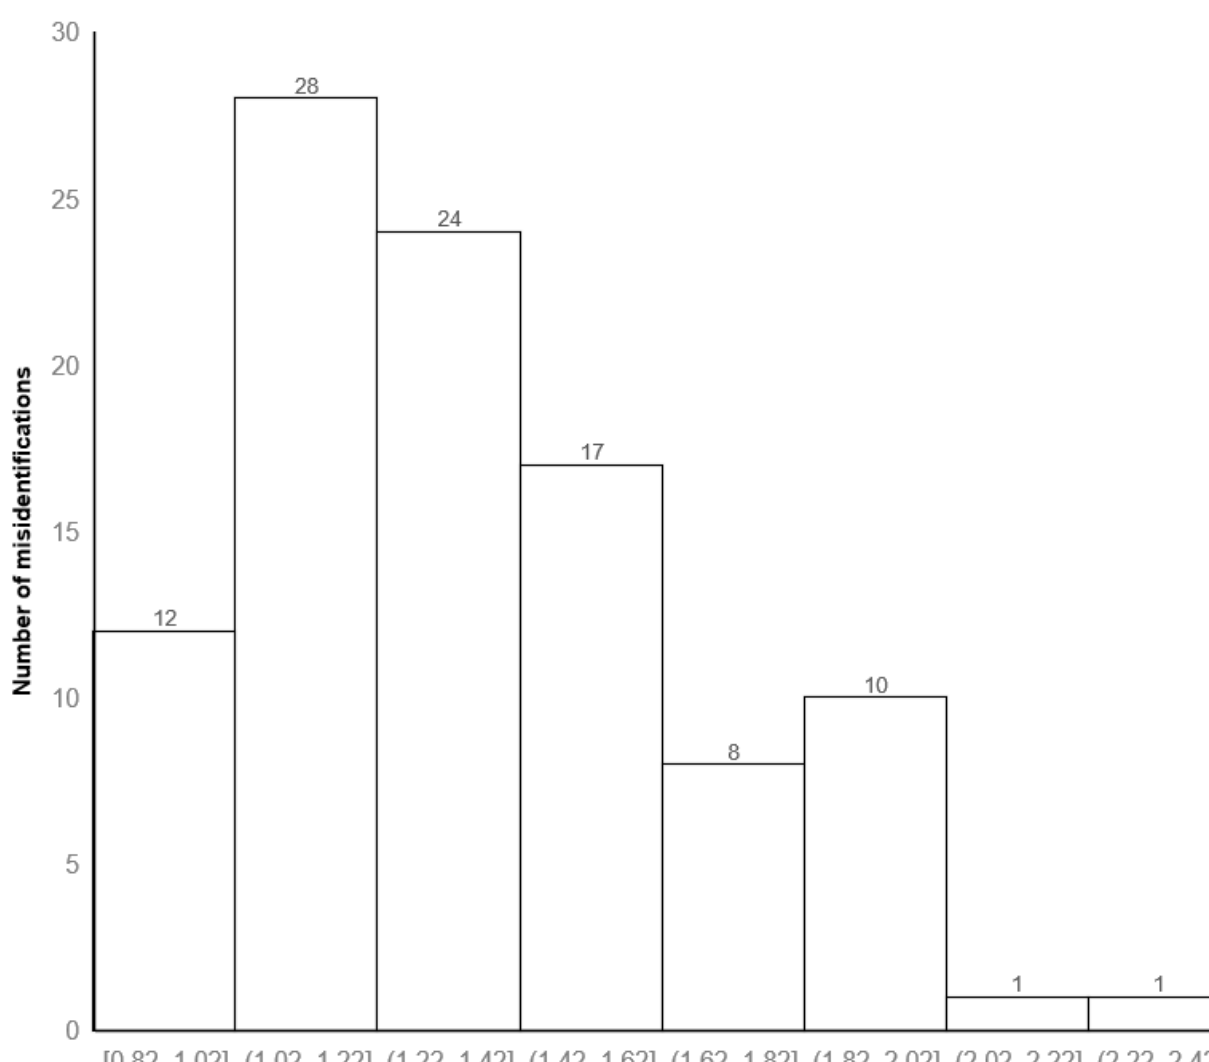
Figure 5. Histogram showing the distribution of misidentified T2 and T6 individuals classified by range of average pore size diameter of 0.20 µm.